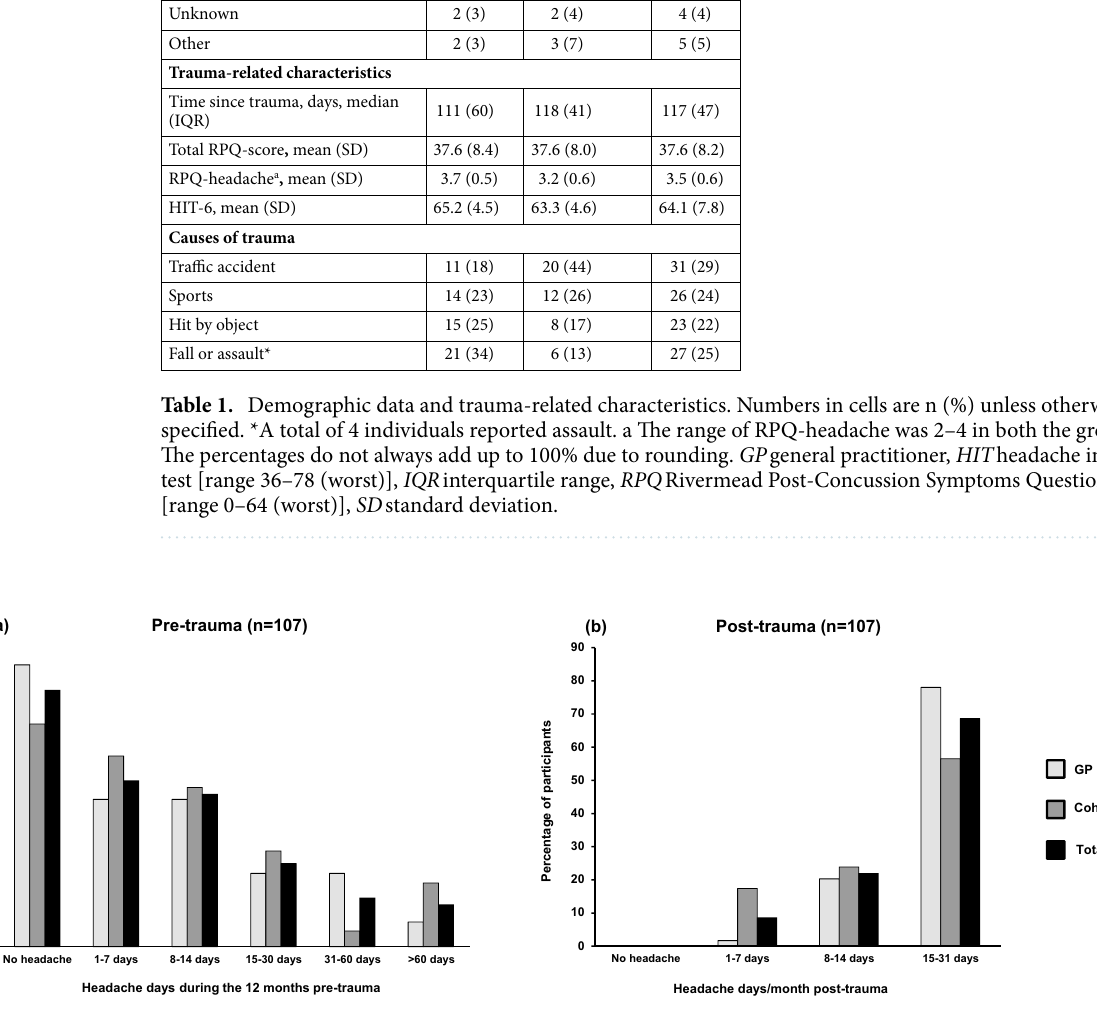
Figure 2. ( a ) Headache days during the 12 months pre-trauma; ( b ) headache days/month post-trauma. GP general